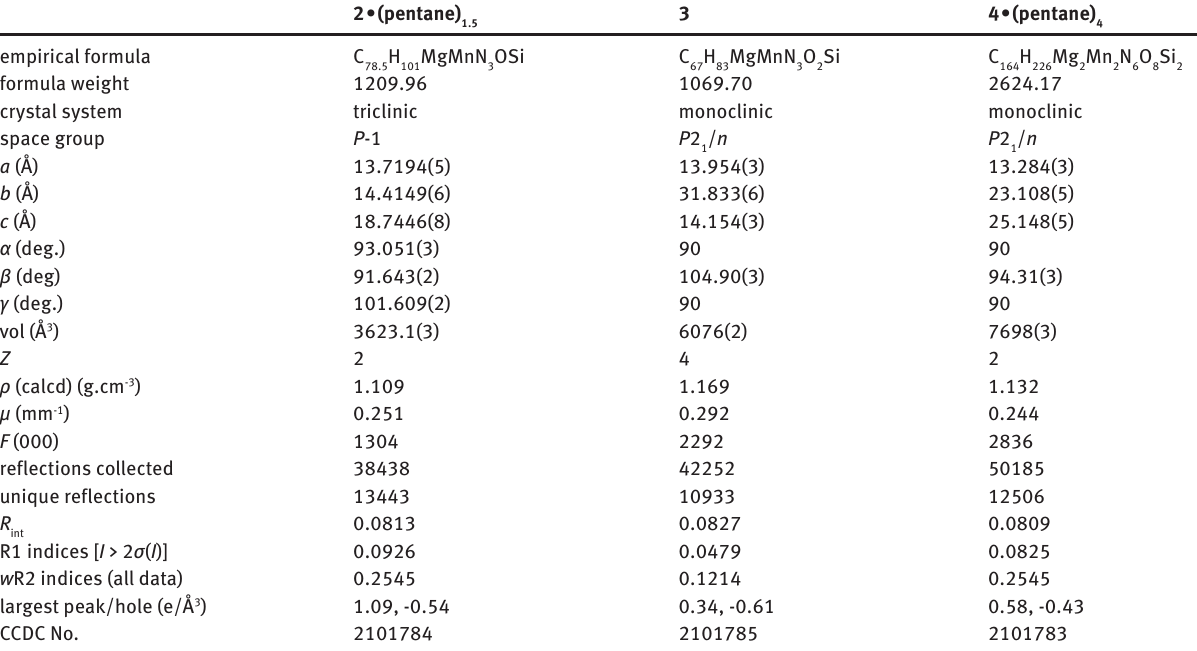
Table 1: Summary of crystallographic data for 2 -